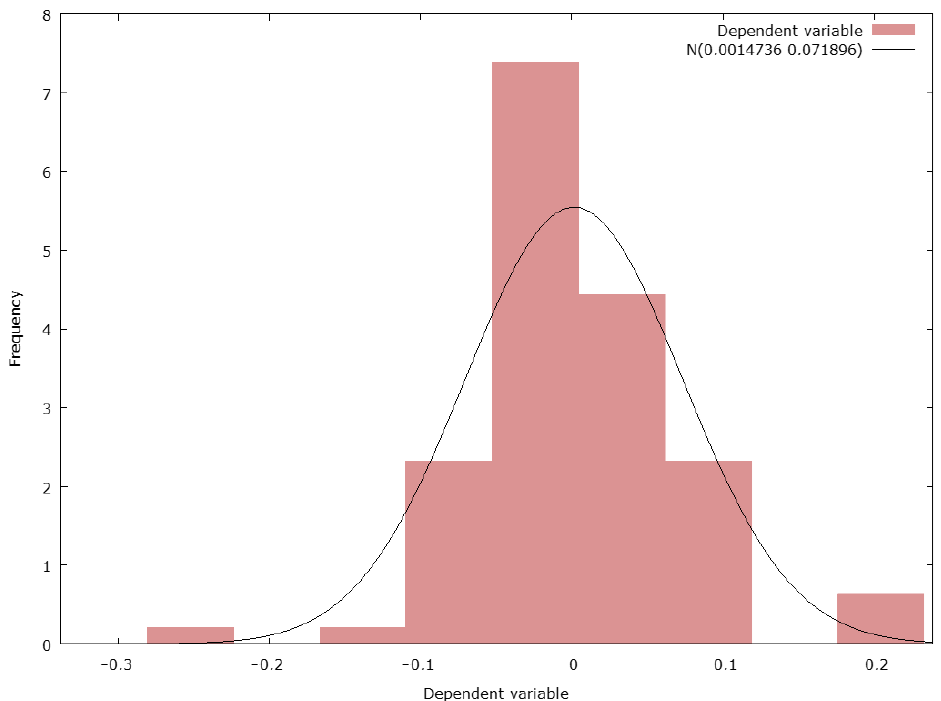
Figure 3. Histogram of the normal distribution of the dependent variable of the Asian model. Table 6. Summary of the American volatility matrix model. Model 3: OLS, Using Observations 1–83